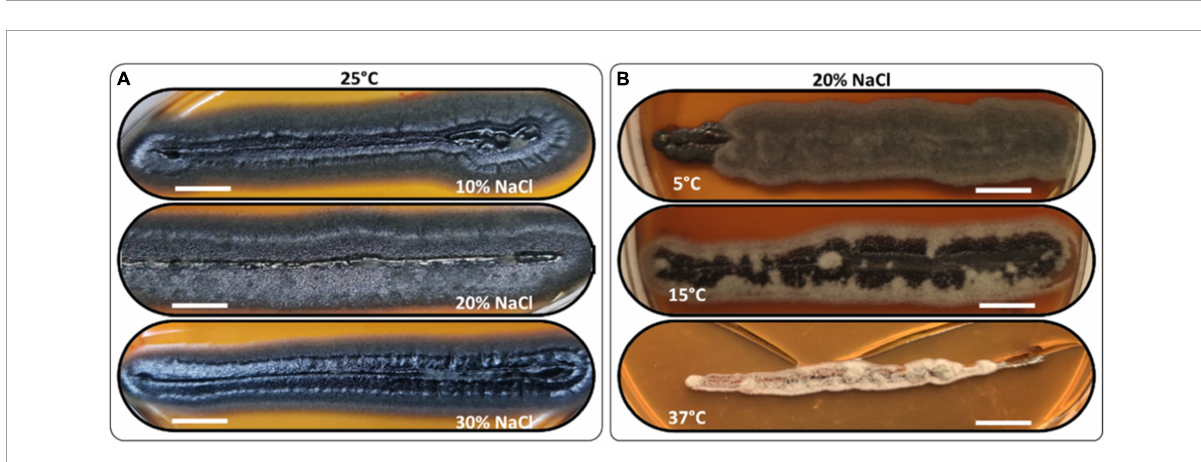
FIGURE4 Morphology examples of H. werneckii isolate GPS5 halotolerance (A) and thermotolerance (B) line-streak growth over MEA media supplemented with 10, 20, and 30% NaCl at 25 ◦ C for 2 months and thermotolerance growth on MEA media supplemented with 20% NaCl at 5 ◦ C, 15 ◦ C, and 37 ◦ C, over 2 months. Bar = 1